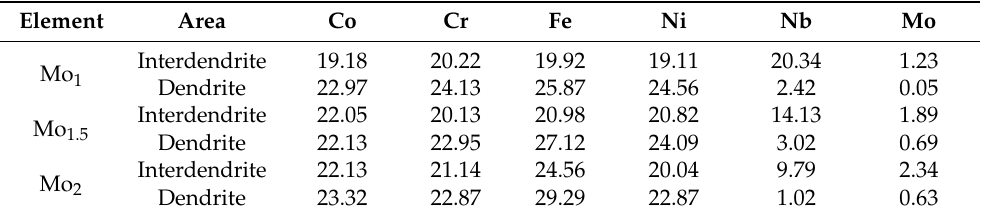
Table 2. Chemical composition of the ((CoCrFeNi) 95 Nb 5 ) 100-x Mo x (x = 1, 1.5, 2) HEA coating prepared under the laser beam power of 800 W (at.%).